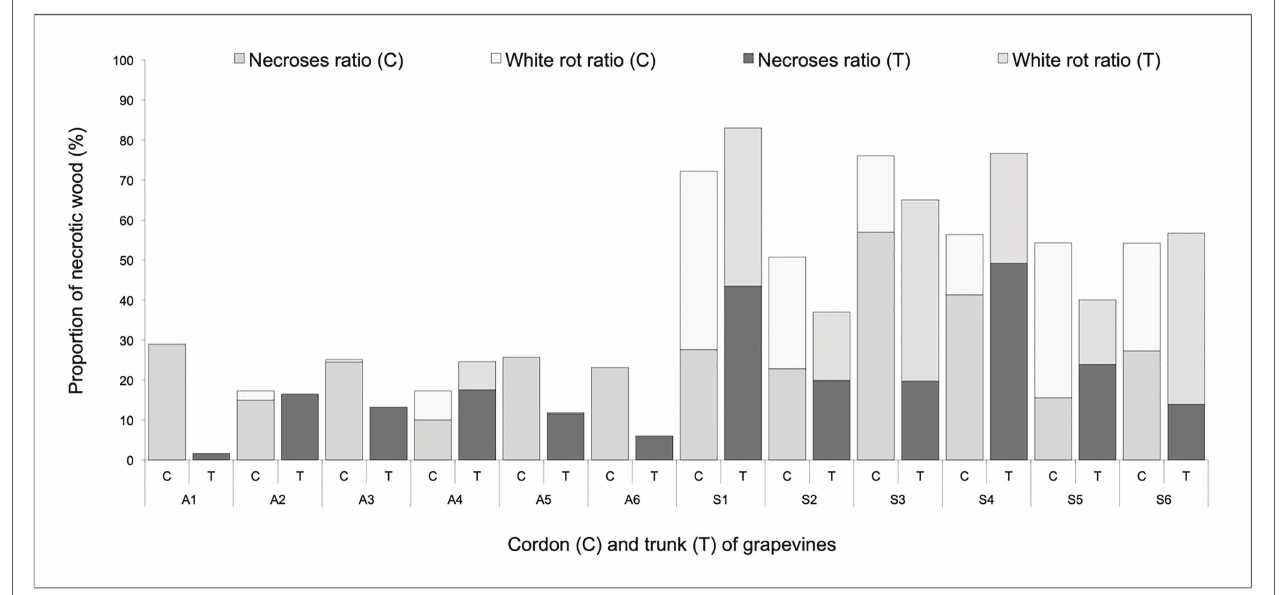
FIGURE 2 | Percentage of necroses and white rots in the trunk wood (T) and cordons (C) of asymptomatic (A) and symptomatic (S) Cabernet Sauvignon